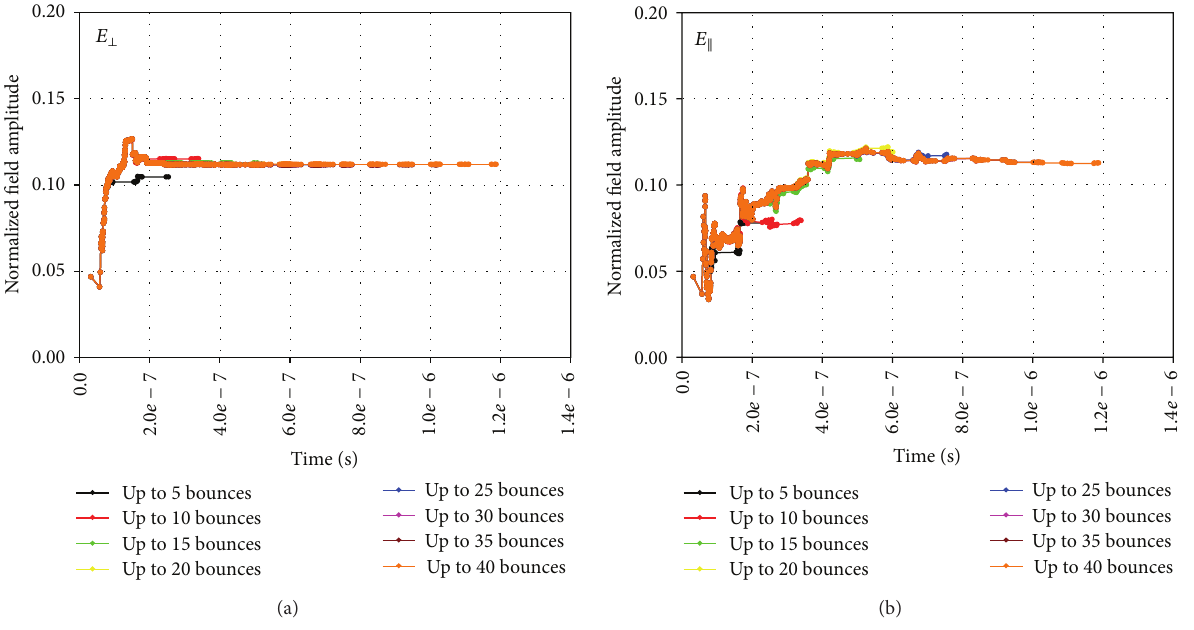
Figure 8: (a) RF field build-up inside a metal-backed dielectric ( 𝜀 𝑟 = 10 − 𝑗5 ; 𝑑 = 5 mm) space vehicle. Frequency = 6GHz; polarization: perpendicular . (Though the field is normalized, the 𝑦 -axis considered is only up to 0.20 to facilitate closer scrutiny of the plots.) (b) RF field build-up inside a metal-backed dielectric ( 𝜀 𝑟 = 10−𝑗5 ; 𝑑 = 5 mm) space vehicle. Frequency = 6 GHz; polarization: parallel . (Though the field is normalized, the 𝑦 -axis considered is only up to 0.20 to facilitate closer scrutiny of the